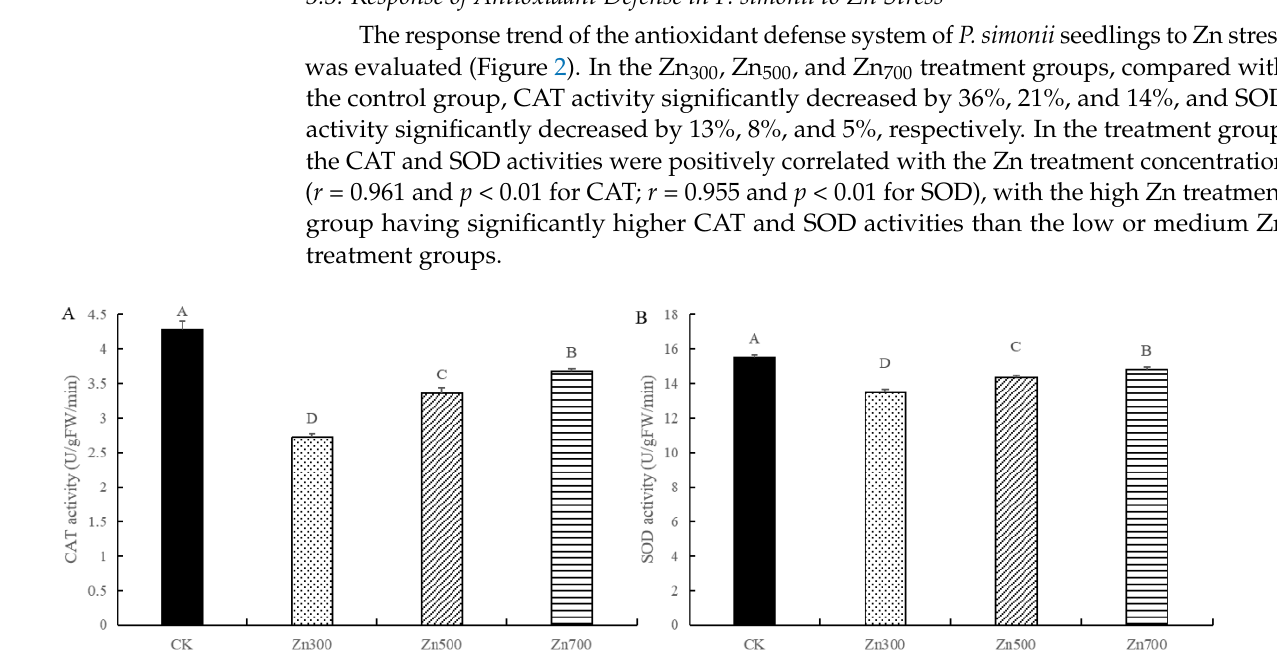
Figure 2. Effects of Zn treatment on CAT ( A ) and SOD ( B ) activities of P. simonii . The values shown in the figure are the average value ± SD (n = 3). Different letters indicate that there are significant differences among groups (one-way ANOVA, p <